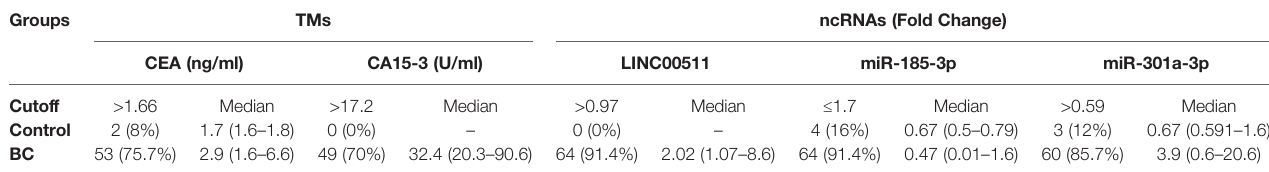
All data are presented as median (range) and the positivity rates are presented as (n,